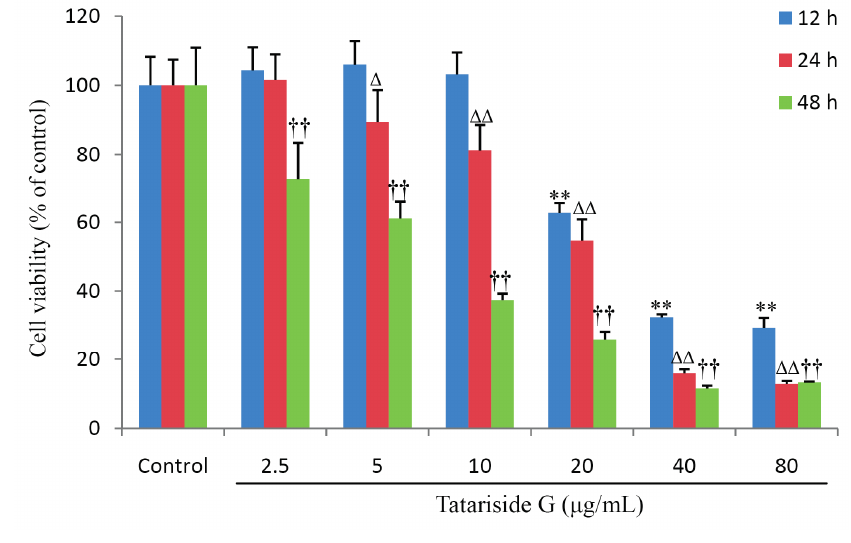
Figure 2. Effects of tatariside G on HeLa cells viability. After cells were treated with designated concentrations of tatariside G for 12, 24, and 48 h, respectively, cell viability was determined by MTT. Δ p < 0.05; **, ΔΔ , †† p < 0.01 compared with the control group. Data are expressed as the mean ± SD. N =